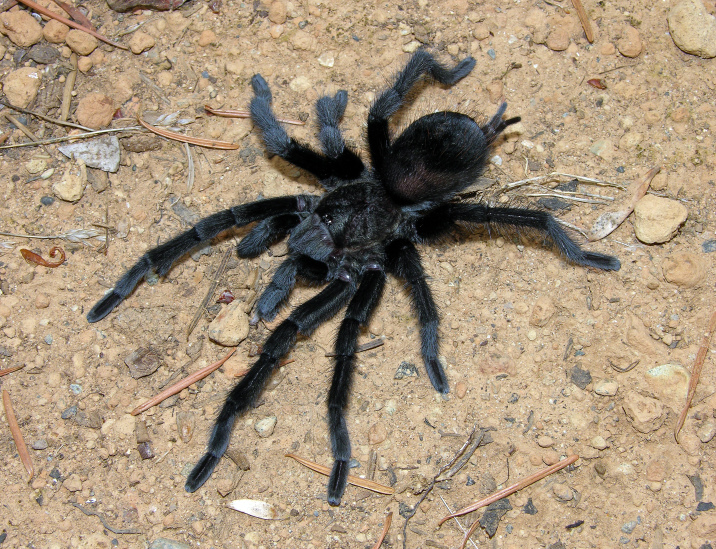
Brachypelma
schroederi Rudloff, 2003 male from Mitla, Oaxaca State, Mexico. Photo: Rick C. West.